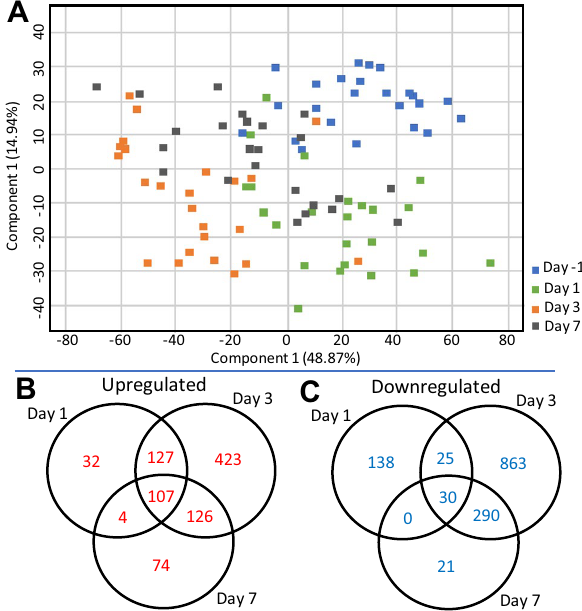
Figure 3. Gene expression changes most pronounced at D3 compared to baseline values. Significantly differentially expressed genes across all animals, irrespective of dose, were identified by repeated measures ANOVA and Benjamini Hochberg FDR correction (p < 0.001) followed by twofold cut-off. ( A ) PCA plot was generated in GeneSpring using the differentially regulated probe-list. ( B ) Venn diagram showing distribution of upregulated genes passing the filtering criteria at different time-points. ( C ) Venn diagram showing distribution of downregulated genes passing the filtering criteria at different